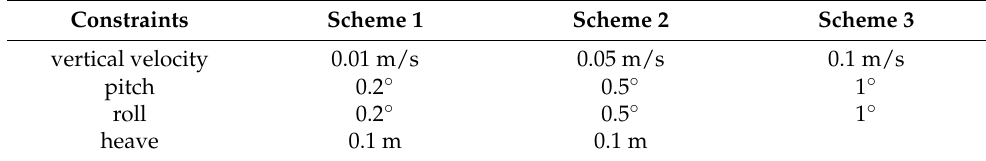
Table 1. Motion constraint schemes.